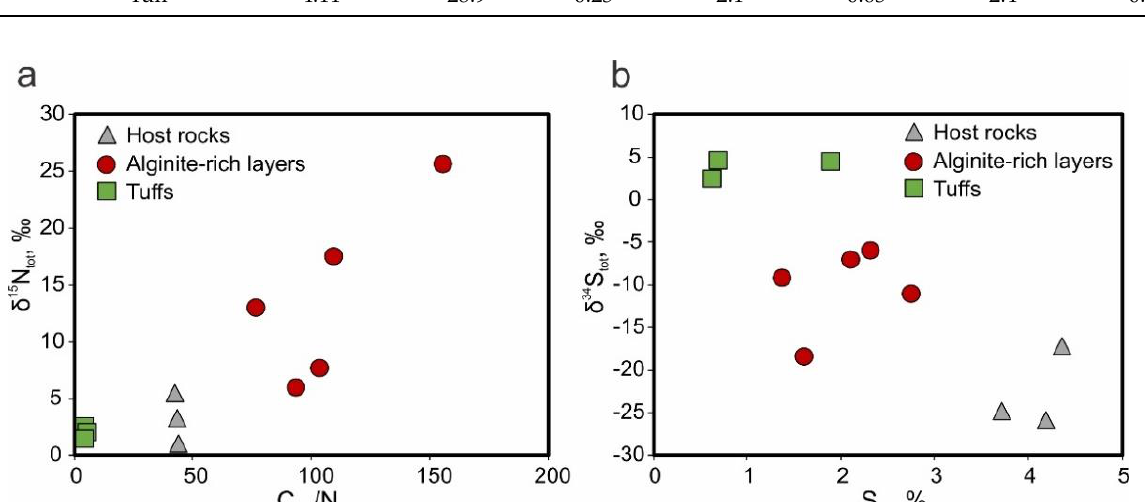
Figure 10. Comparison of δ 15 N tot values and C org /N tot ratio ( a ), and comparison of δ 34 S tot values and S tot content ( b ) in the alginite-rich layers, host rocks, and tuffs.